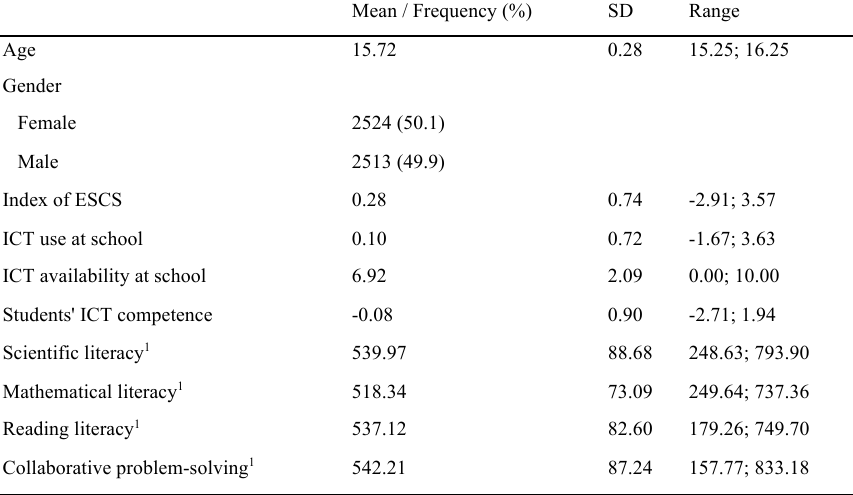
Table 1. Means, frequencies, standard deviations, and ranges of the study